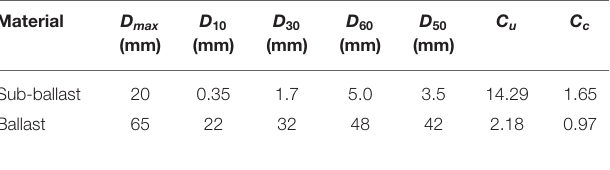
TABLE 1 | Grain size characteristics of ballast and sub-ballast.